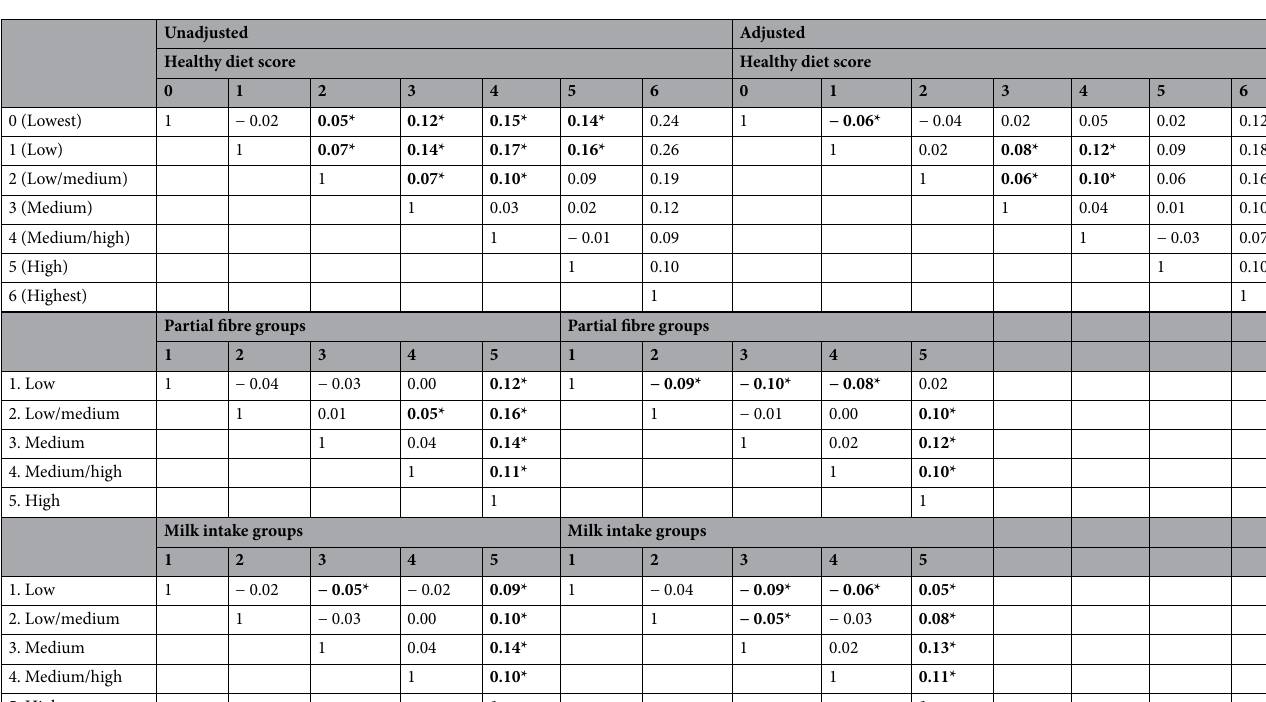
Table 5. Posthoc comparisons for unadjusted and covariate adjusted analyses using Bonferroni. Mean differences (columns-rows) shown. * shows mean difference is significant at the 0.05 level.